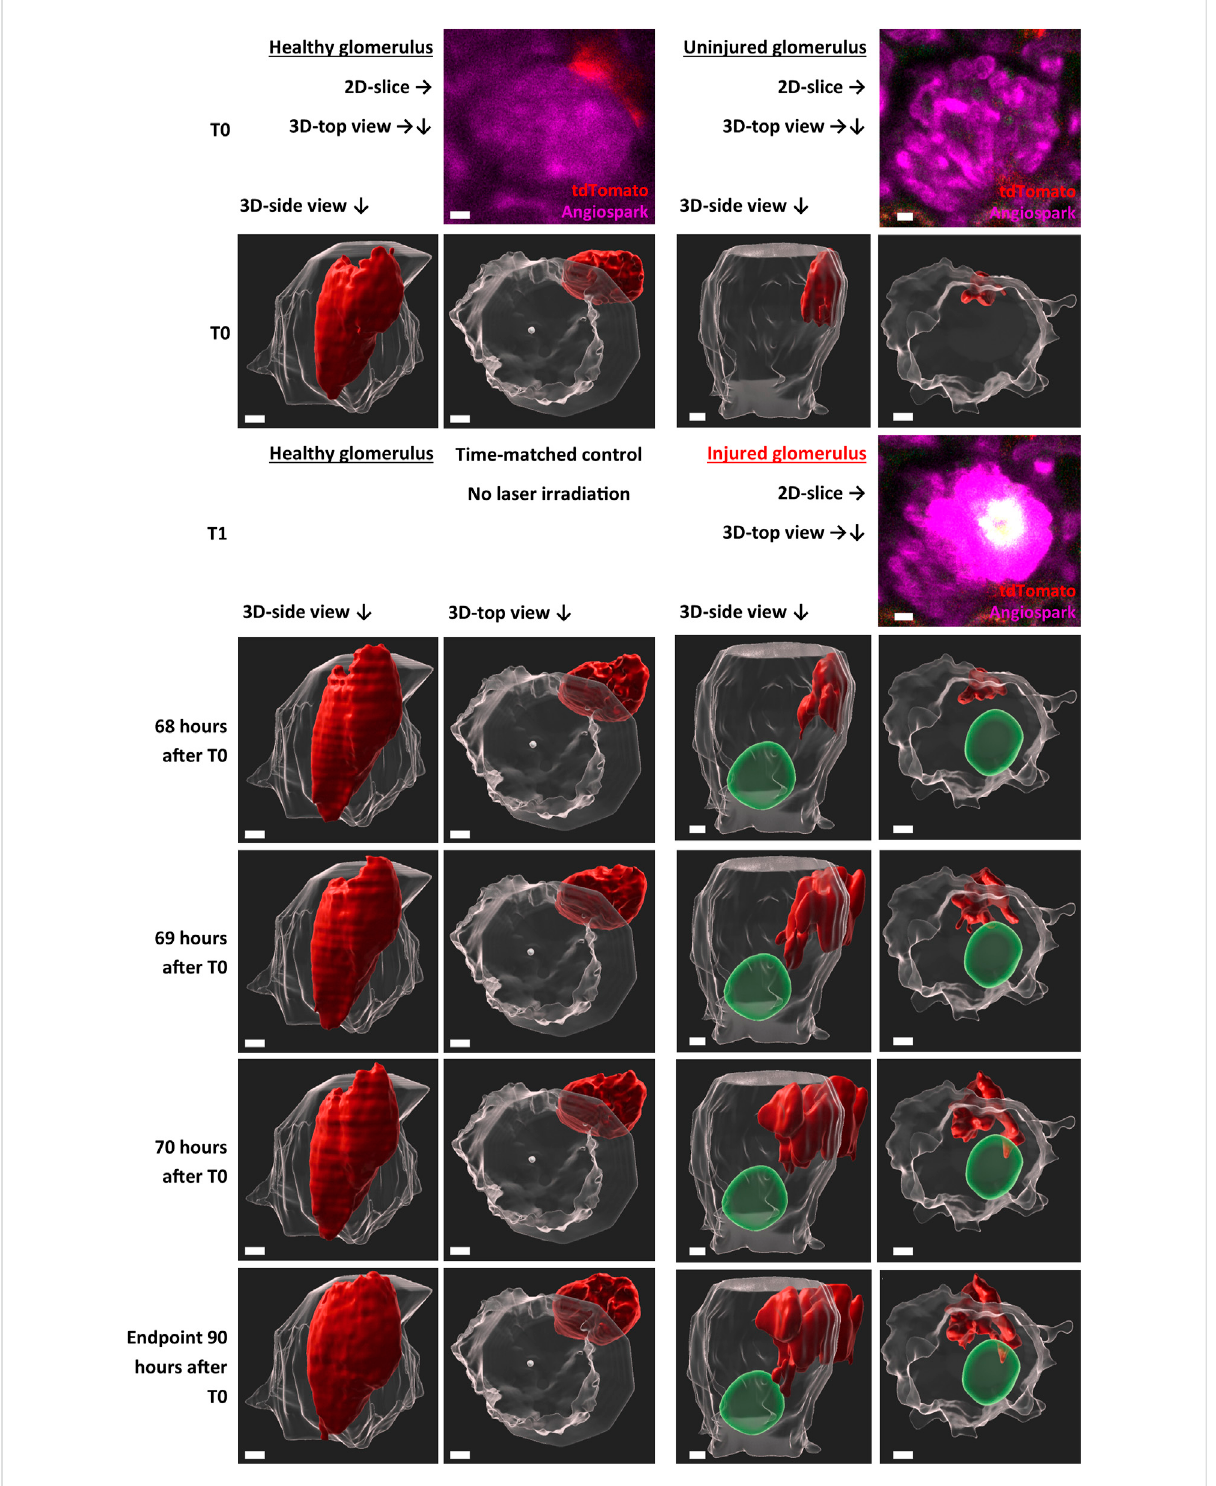
FIGURE 3 Representative intravital imaging data of physiological renin cell motion and pathophysiological migration. Z-stack imaging data of two time- matched glomeruli were rendered with Imaris 9.7.2 for the shown time points. T1 (laser irradiation) was applied in one glomerulus (right side). The individual migration in the injured glomerulus began after 68 h. Two three-dimensional-view points are given, side view of the glomeruli and top view along the Z -axis. TdTomato-labelled renin cells are presented in red. The auto fl uorescence of the laser injury was rendered in green. Glomerular border and center, automatic calculated with object statistics in Imaris 9.7.2 are marked in transparent white. White scale bars represent 10